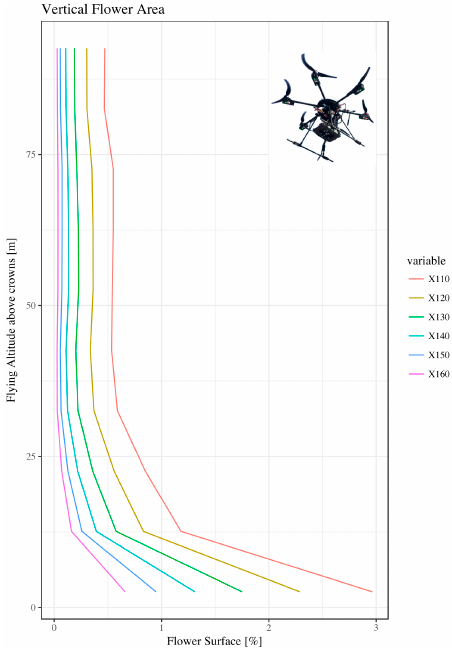
Figure 3. Vertical flower surface (%) for the Flying Altitude (FA) of 2.6–92.6 m above crowns. Graphs are based on different thresholds (X110–X160) in the blue channel. The analyzed 50 × 50 m 2 area is summarized by dividing it into 40 by 80 subareas (Figure 4). Each subarea is represented by a 6.0 × 10.4 m 2 grid. The average detected flower area covered 1.33% (threshold 140) out of the total area under study. The minimum (maximum) detected flower area is 0.212% (2.612%). The highest (lowest) flower concentration occurs in field E1 (H1). Figure 4 shows that fewer flowers are present in the southeastern part of the area.